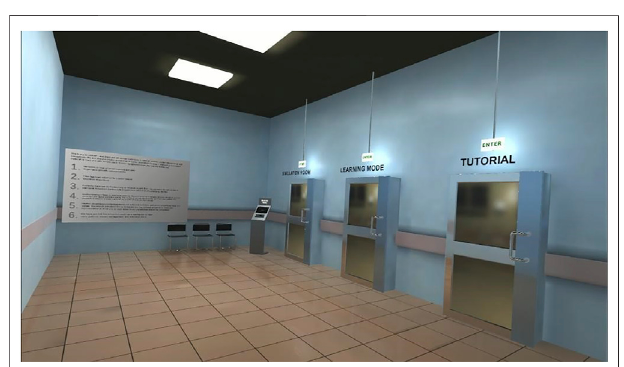
FIGURE2| Theinitialroomtheuserenters,thesedoorsactasamenuto enter a tutorial, learning mode, or unguided interactive simulation.